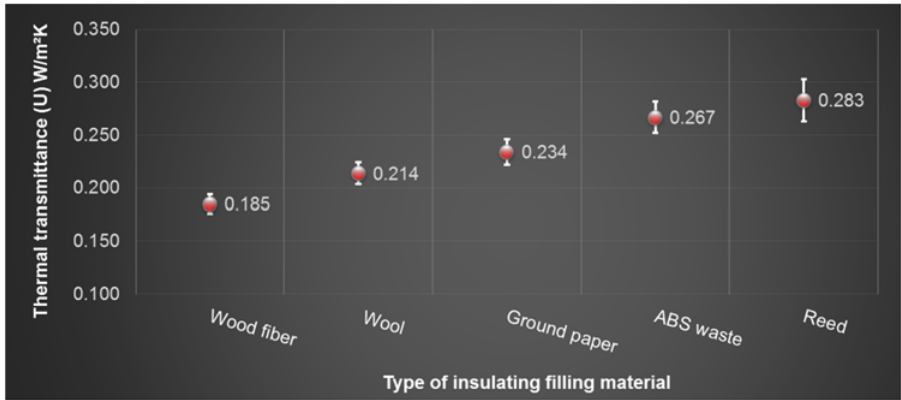
Figure 5. In situ measured thermal transmittance ( U ) values for the experimental wall structures.